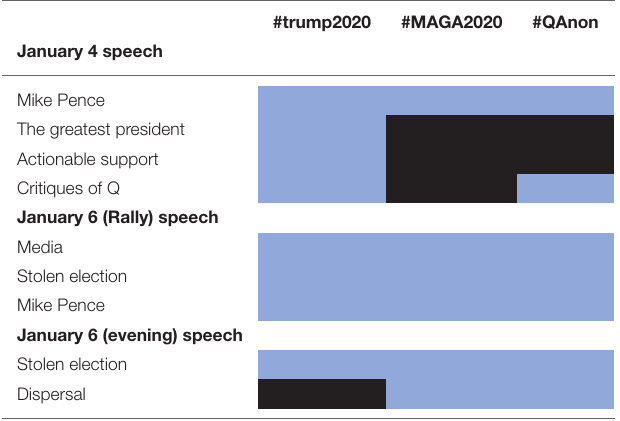
TABLE 2 | Summary of the